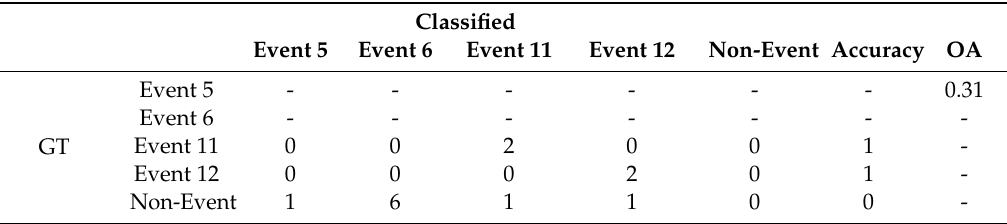
Event classification using the VideoGraph only approach for one VIRAT video: